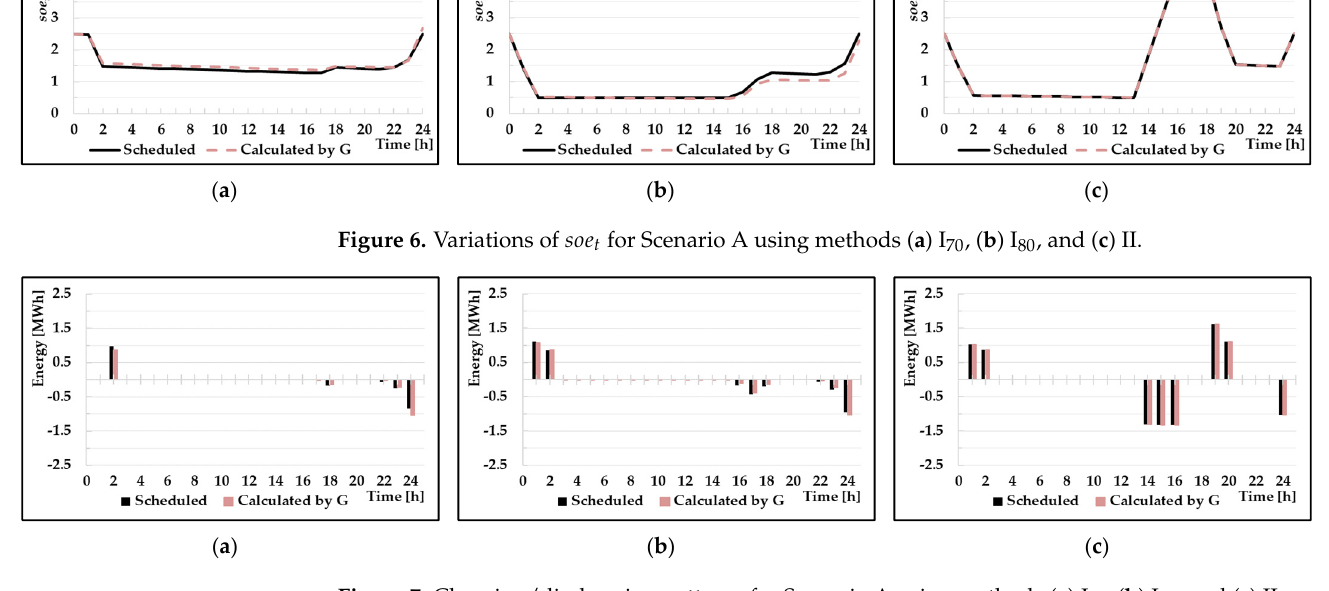
Figure 7. Charging/discharging patterns for Scenario A using methods ( a ) I 70, ( b ) I 80 , and ( c ) II. Case I 80 –B is similar to the actual value of